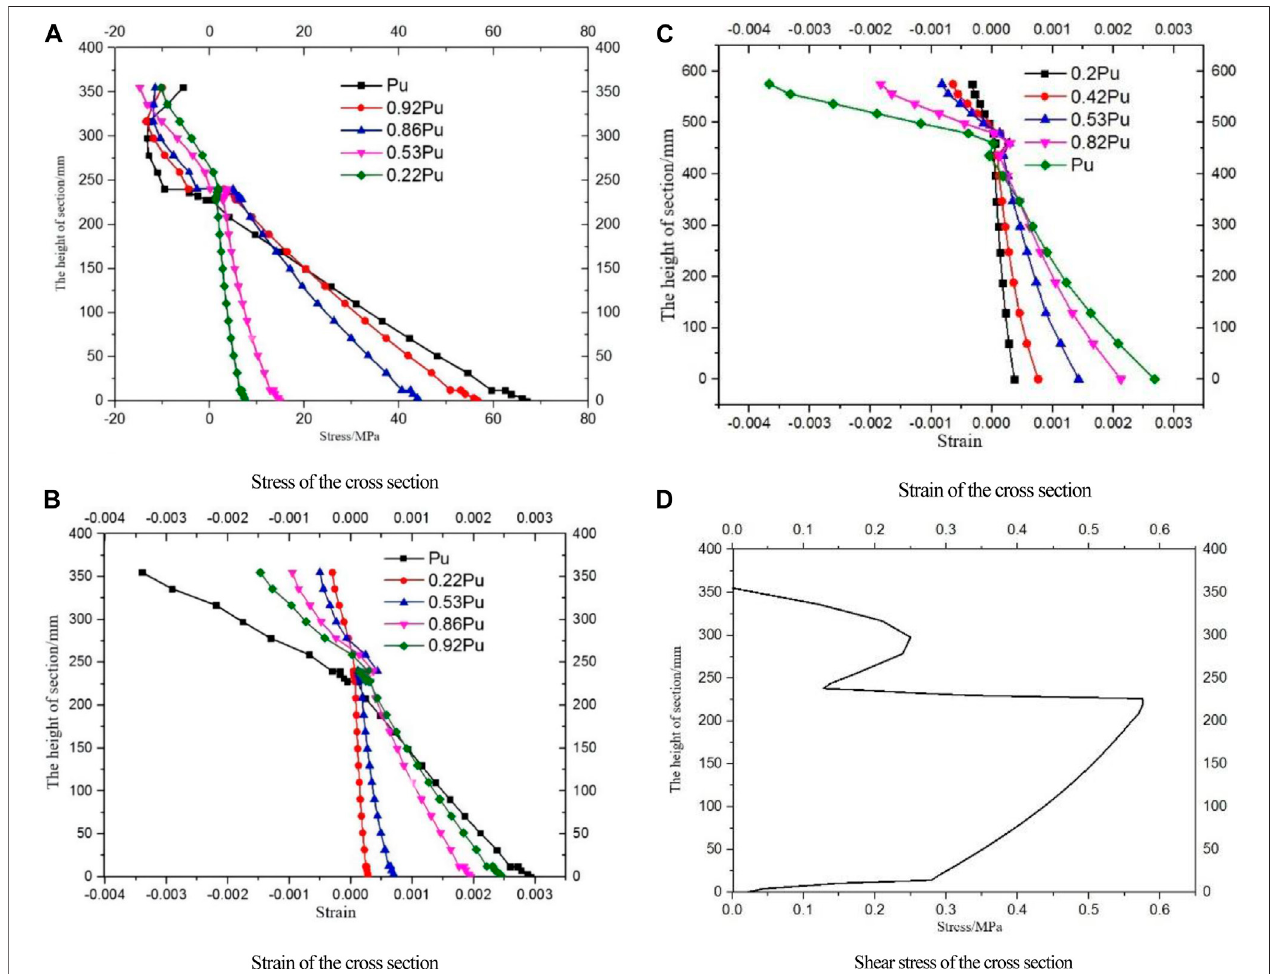
FIGURE 13 | Stress and strain of the cross section at the mid-span of Beam B5-2. (A) Stress of the cross section at the mid-span of B5-1. (B) Strain of the cross section at the mid-span of B5-1. (C) Strain of the cross section at the mid-span of Beam B5-2. (D) Shear stress of the cross section at the mid-span of Beam B5-2.